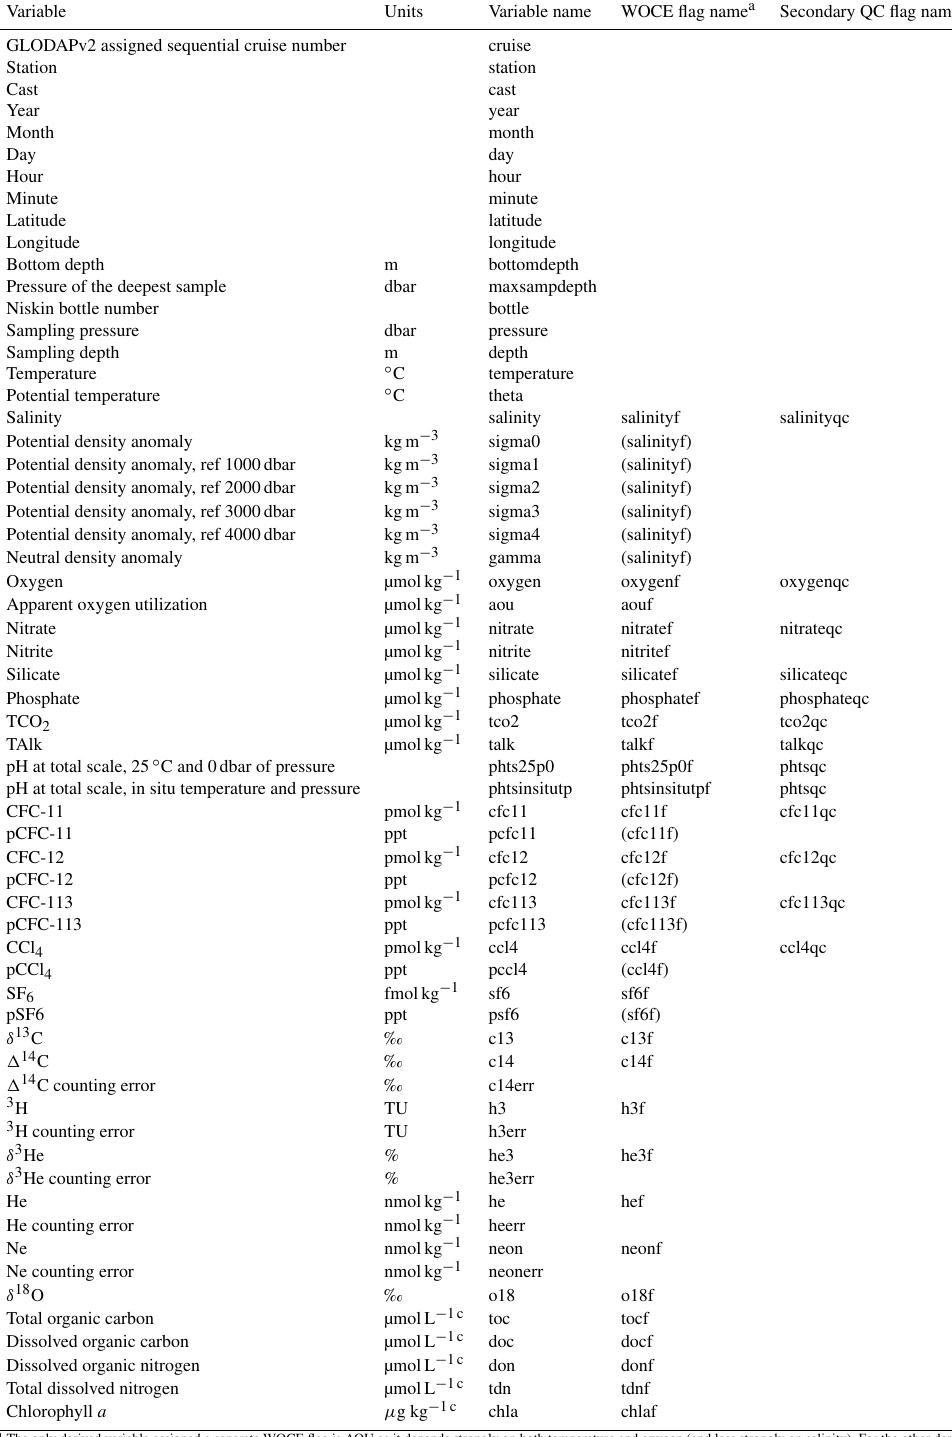
Table 10. Variables in the GLODAPv2 comma separated (csv) product files, their short names, and units, in order of appearance. In the MATLAB product files that are also supplied, a “G2” has been added to every variable